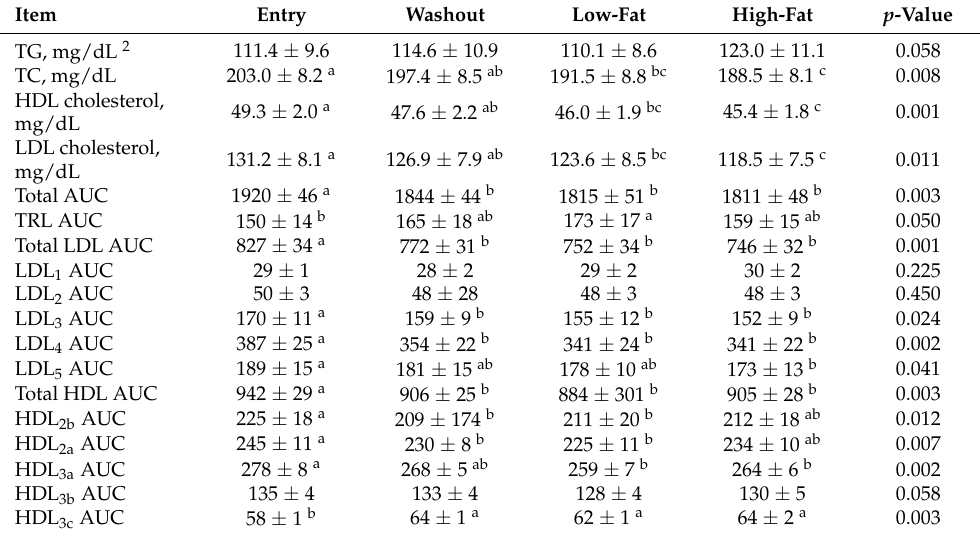
Table 4. Lipoprotein cholesterol and triglyceride concentrations and area under the curve for lipopro- tein subfractions for men at entry and after consumption of ground beef patties initially containing 6 g fat/patty (Low-fat) and 27 g fat/patty (High-fat) 1 .